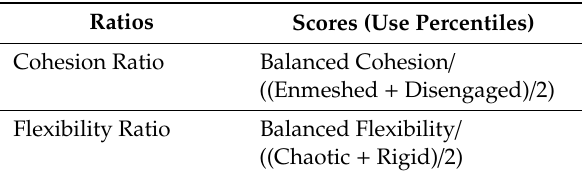
Table 1. Formulas for ratio